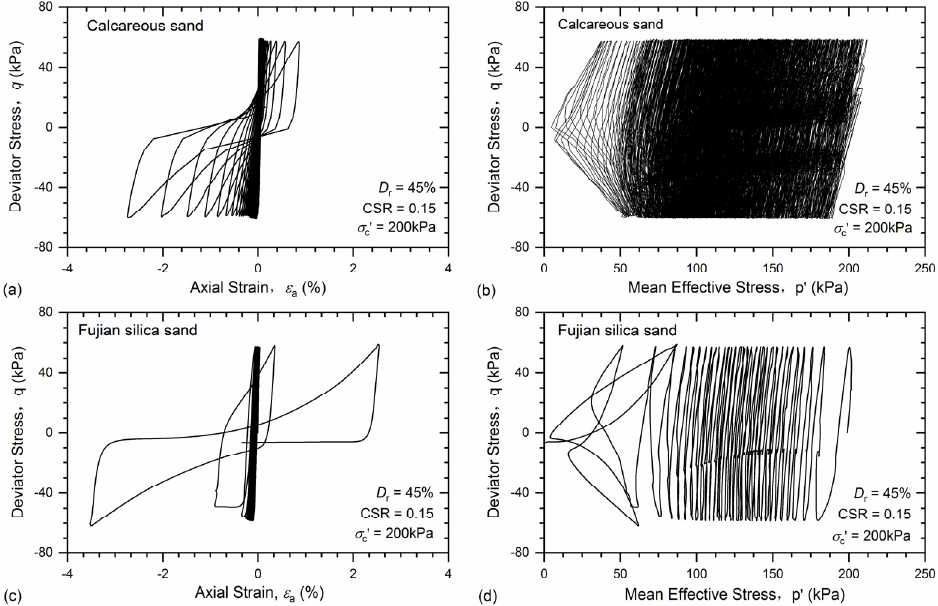
Figure 4. Typical cyclic behavior: ( a ) stress–strain curve for calcareous sand, ( b ) effective stress path for calcareous sand, ( c ) stress–strain curve for Fujian silica sand, ( d ) effective stress path for Fujian silica sand.